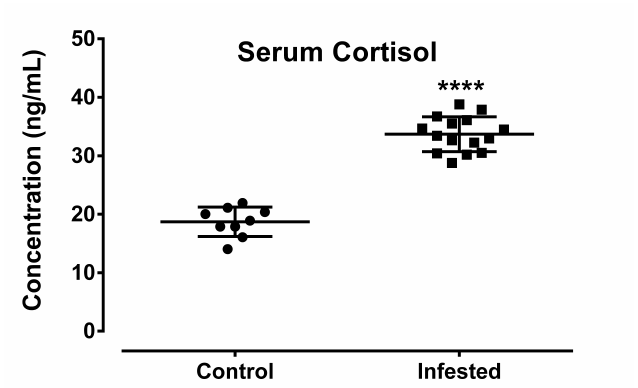
Figure 6. E ff ect of crusted scabieson serum cortisol concentration in a porcine model. Data in scatter plot are shown as mean ± SD. t -test was performed to find out significant di ff erence between the two groups. **** denotes p ≤ 0.0001.